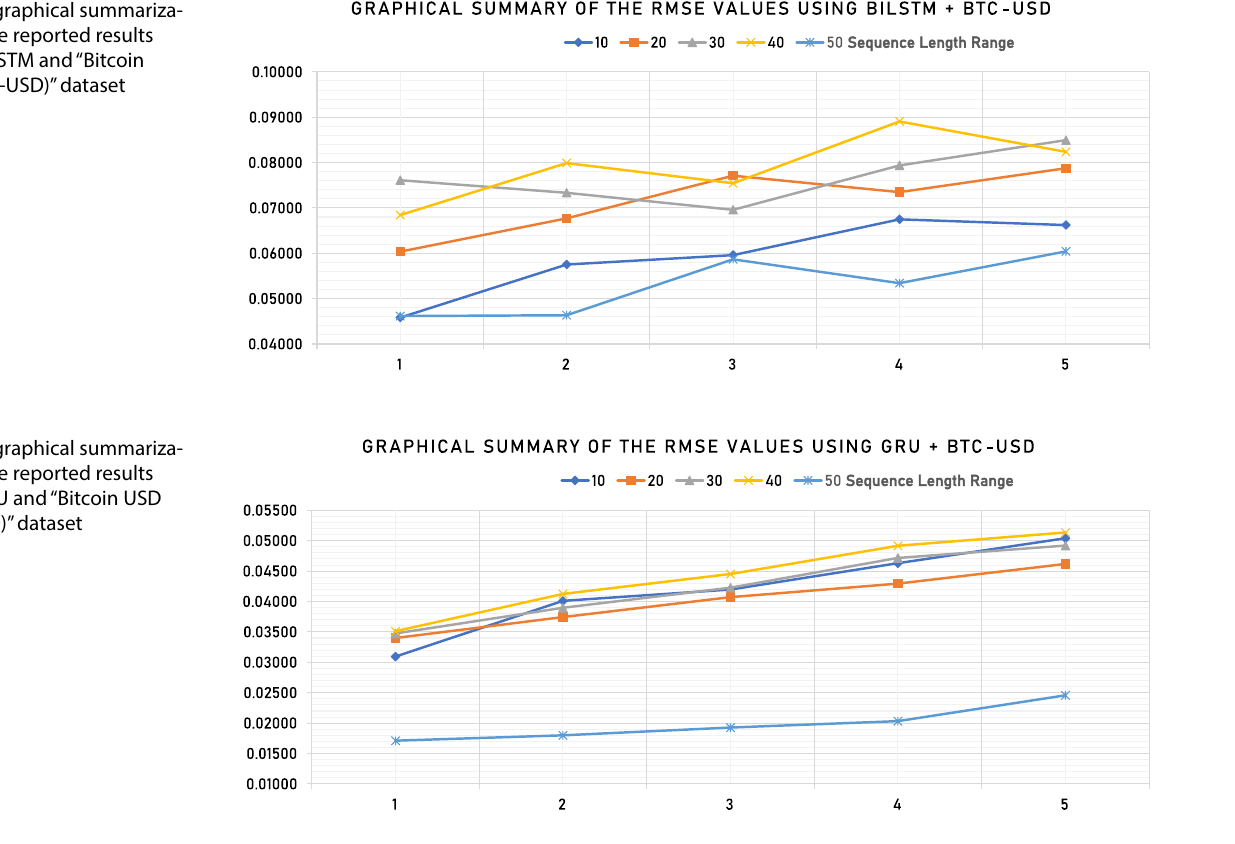
Fig. 8 A graphical summariza- tion of the reported results using BiLSTM and “Bitcoin USD (BTC-USD)” dataset